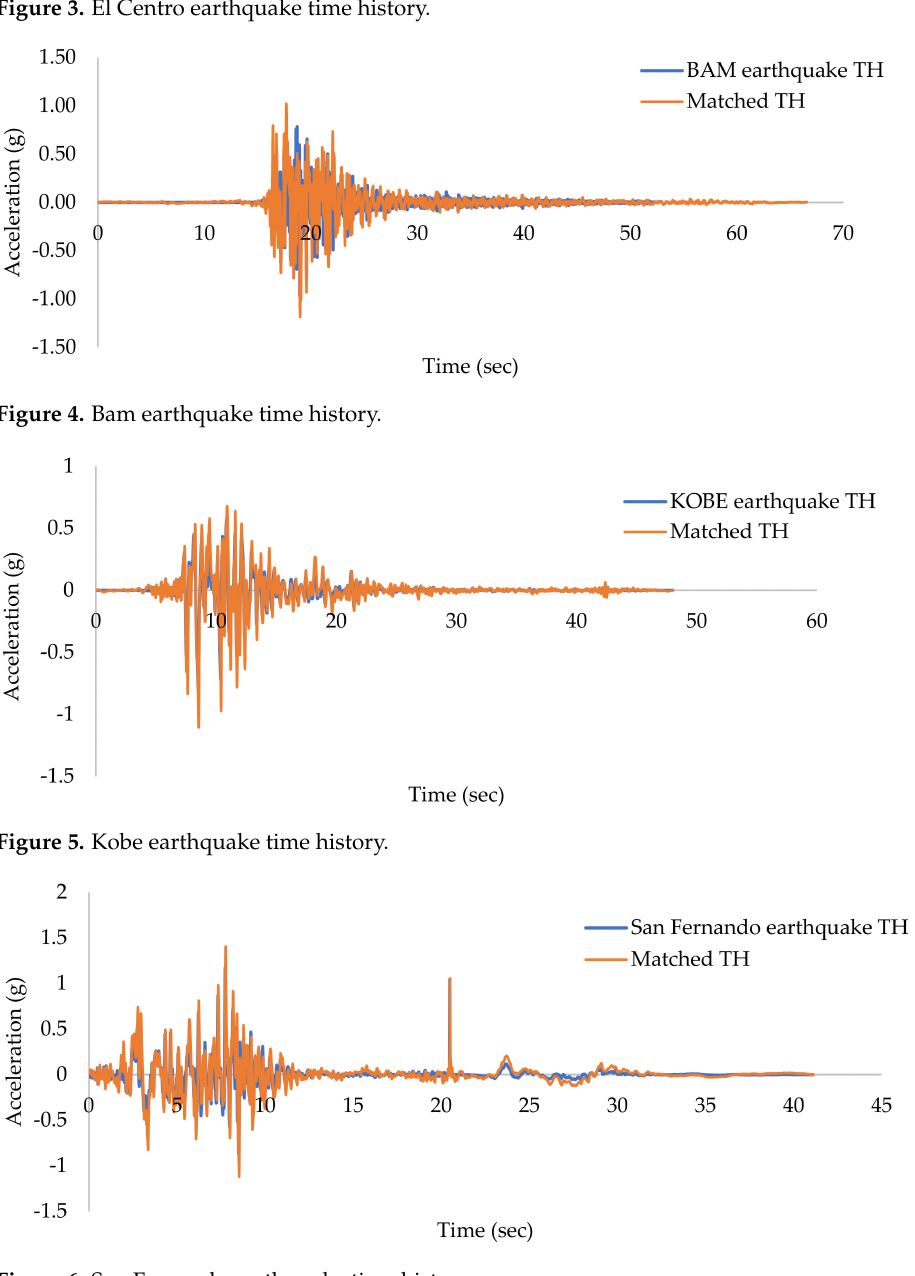
Figure 6. San Fernando earthquake time